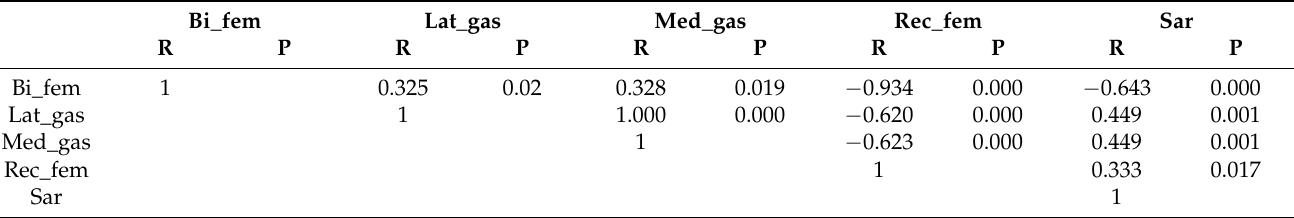
Table 1. Correlation between lower limb muscles.